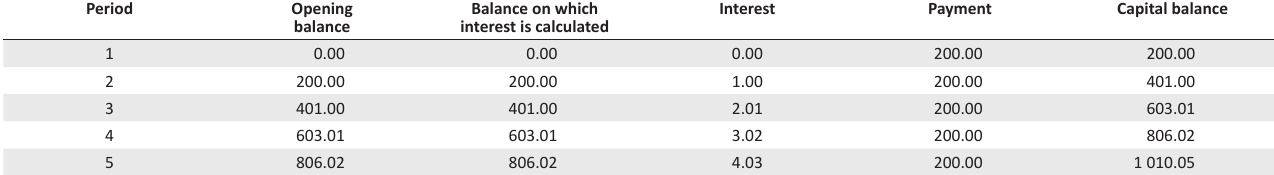
TABLE 2: Annuity payments made at the end of the month. Period